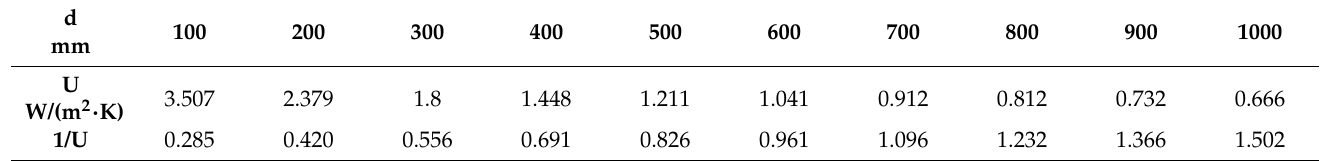
Table 4. Relationship between Thickness and the Heat Transfer Coefficient.